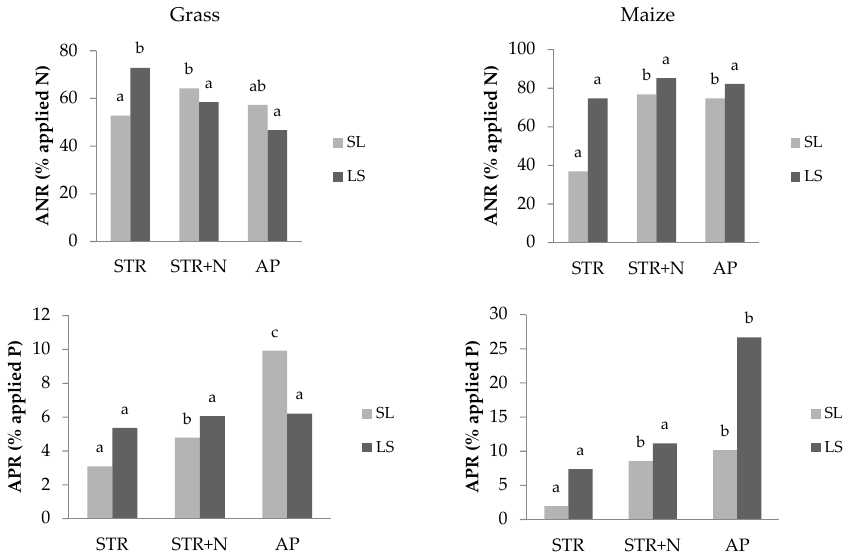
Figure 2. Apparent recovery of applied N (ANR) and P (APR) in maize and grass (%) at SL and LS soils. a, b, c—homogeneous groups. Values followed by the same letters in the column (separately for soils: SL and LS) are not statistically different (Tukey HSD multiple range test, 95.0% significance, P < 0.05).